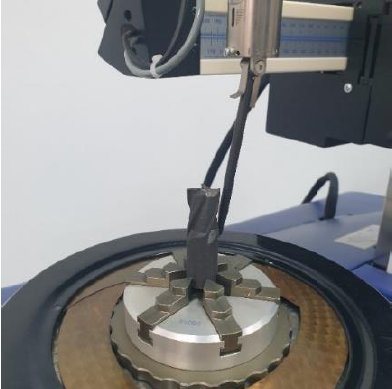
Figure 5. Measurement of the roundness and cylindricity profiles of the shank.